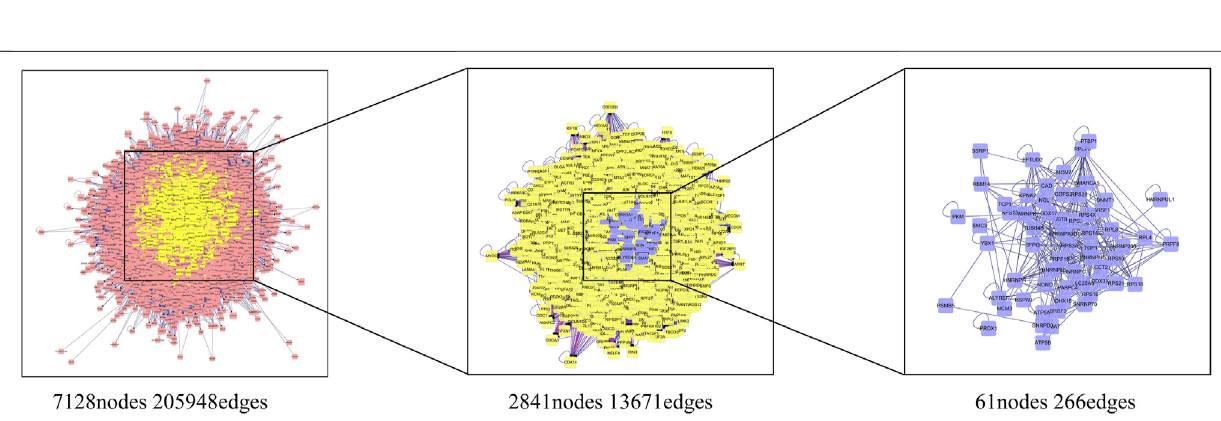
Frontiers in Molecular Biosciences |